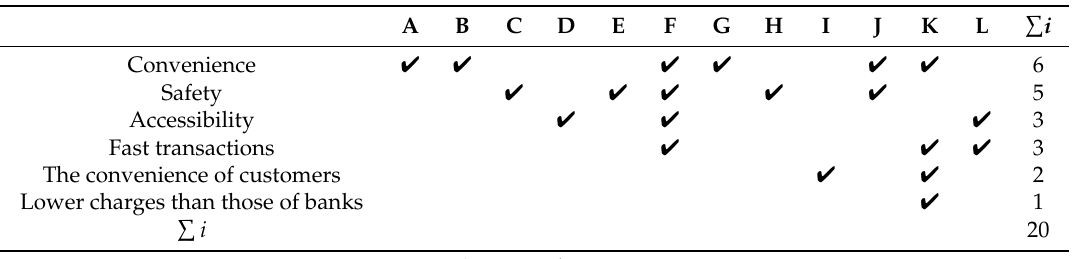
Table 6. Motivations in adopting the Mobile Money Services